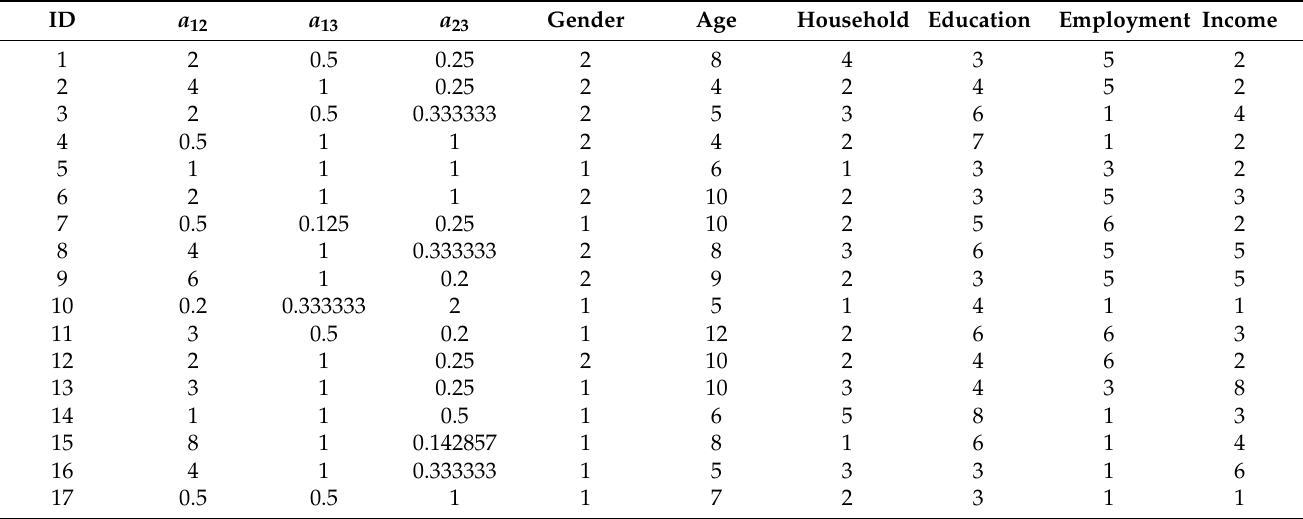
Table 1. Initial data on AHP pairwise ratios and